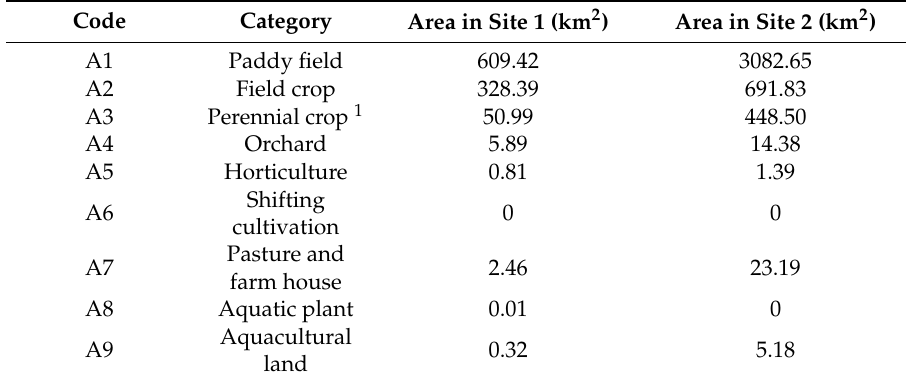
Table 7. Classification system for level 2 of agricultural land and the area of each class.